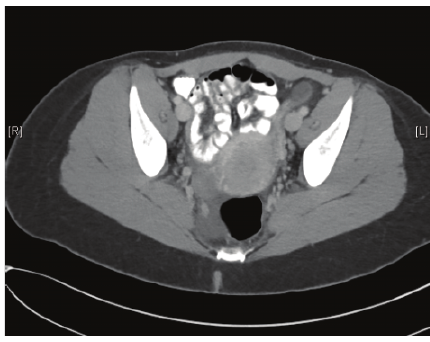
Figure 1: CT scan.